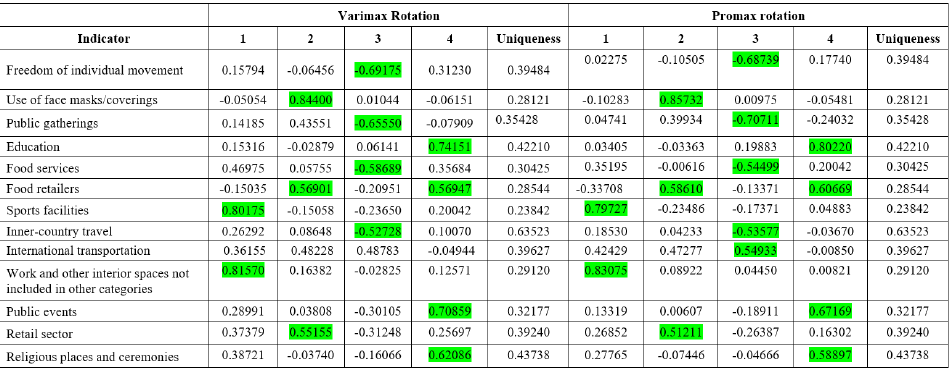
Table 5: Factor Loadings (Rotated)